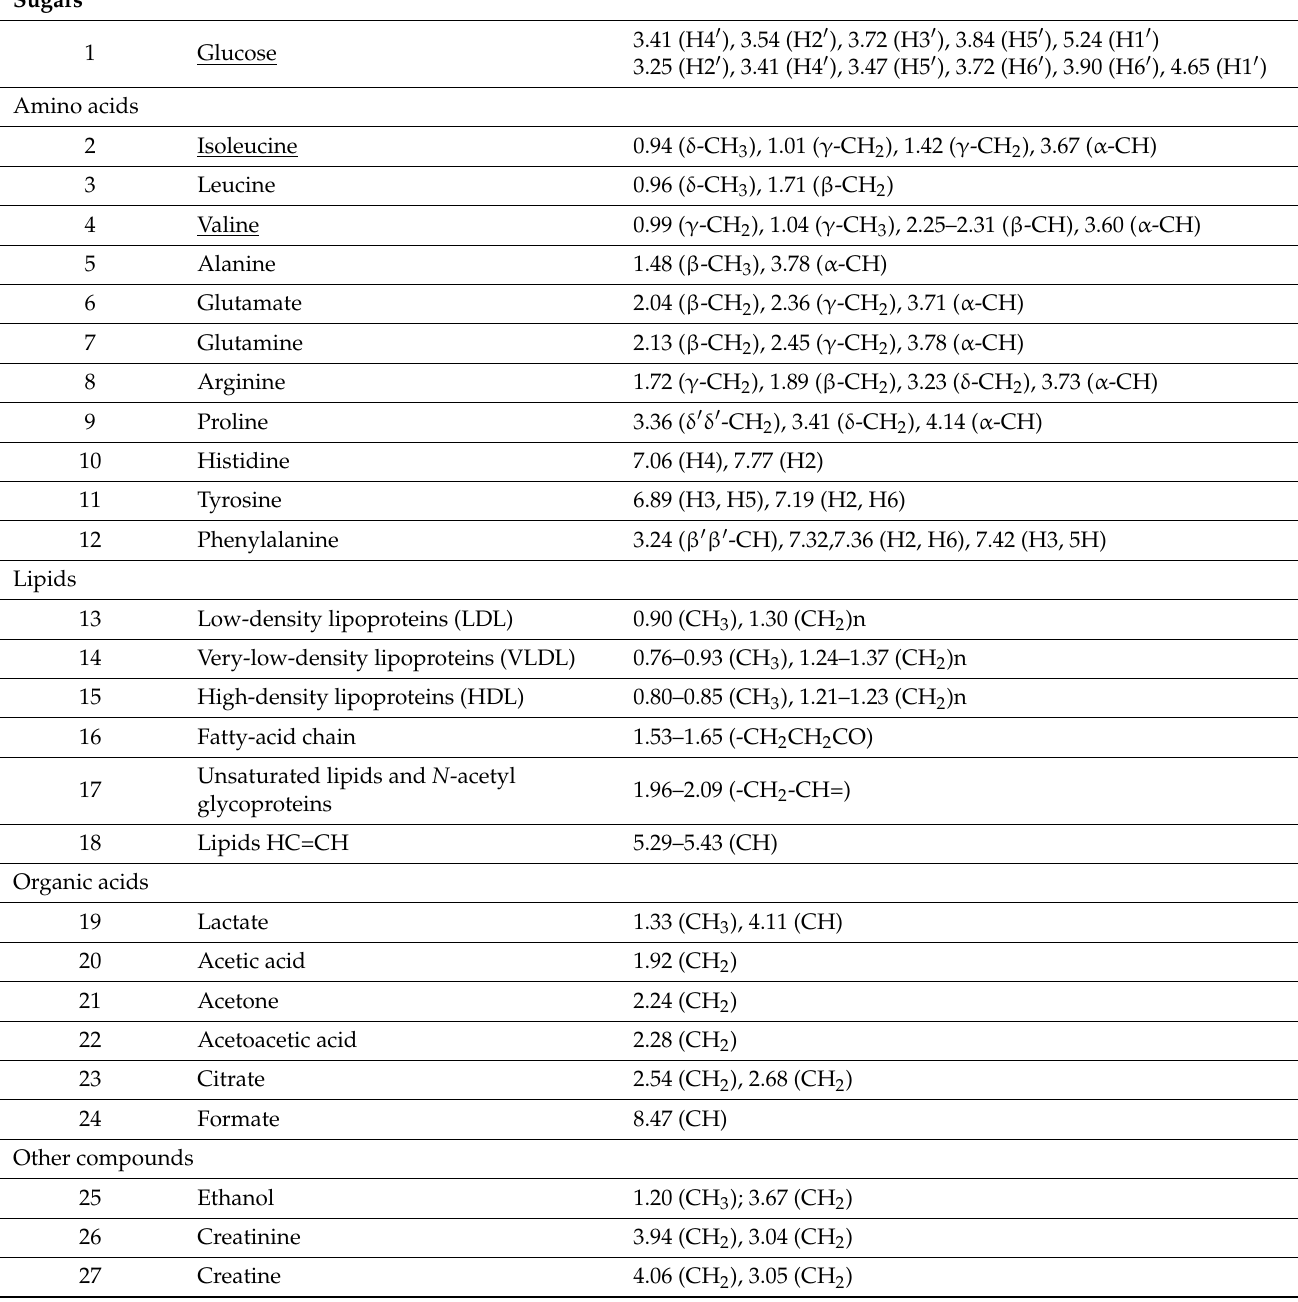
Table A1. 1 H-NMR chemical shifts assignments of the metabolites found in the plasma of patients and controls. Metabolites were identified according to the variables of importance in projection (VIPs) by the PLS-DA model are shown underlined for the comparison between patients and controls and between patients with refractory MTLE and responsive